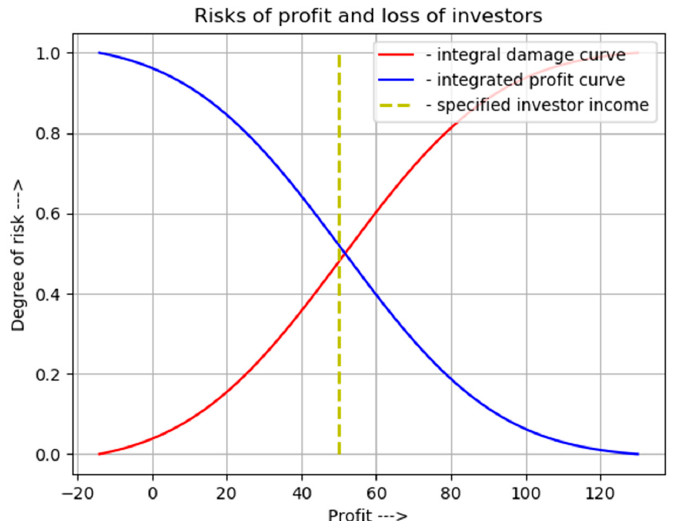
Figure 5. Integrated profit ( P r ) and loss ( P l ) curves for investors in the project of production of raw materials for bioethanol from wheat according to their requirements (minimum profit— P s = 50$/ton)